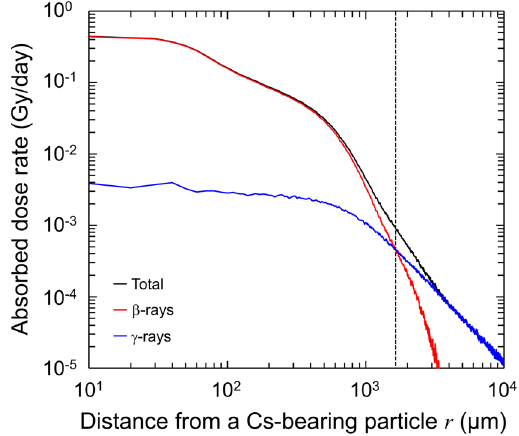
Figure 2. Absorbed dose-rates as a function of distance from a Type B particle. The absorbed dose-rate was calculated by using a Monte Carlo code with PHITS, in which the dose in the area within 1.65 mm (presented as a dotted line) away from the particle is deposited dominantly by β -rays in comparison with dose by γ